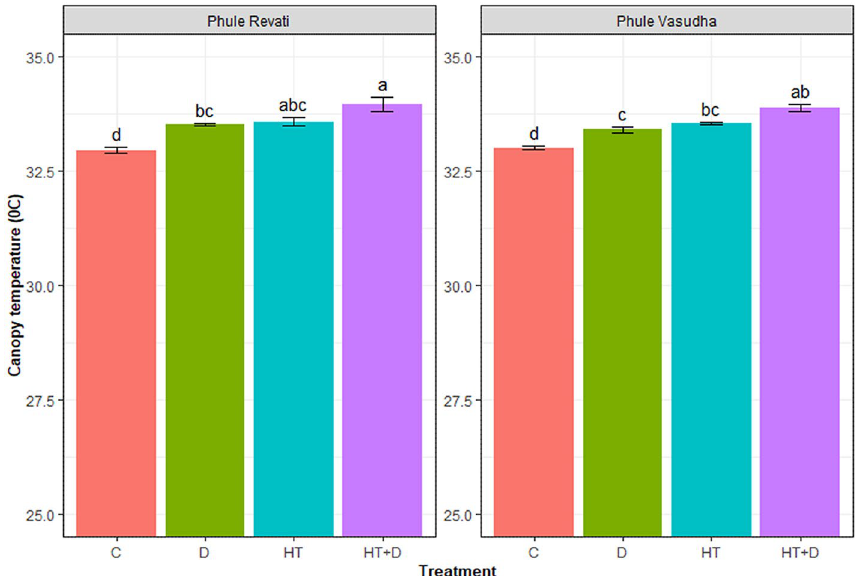
Figure 1. Canopy temperature of Phule Revati and Phule Vasudha under control (C), drought (D), heat (HT), and heat + drought (HT + D) stress treatments. The data represent mean values ± SE (n = 8). Bars with different letters indicate significant differences (P <